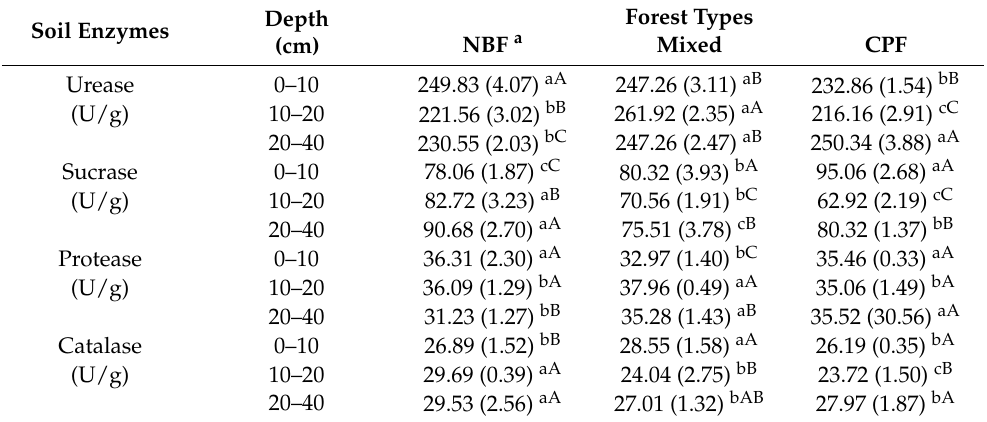
Table 3. Soil enzymatic activity at three soil depths along NBF, mixed forest, and CPF